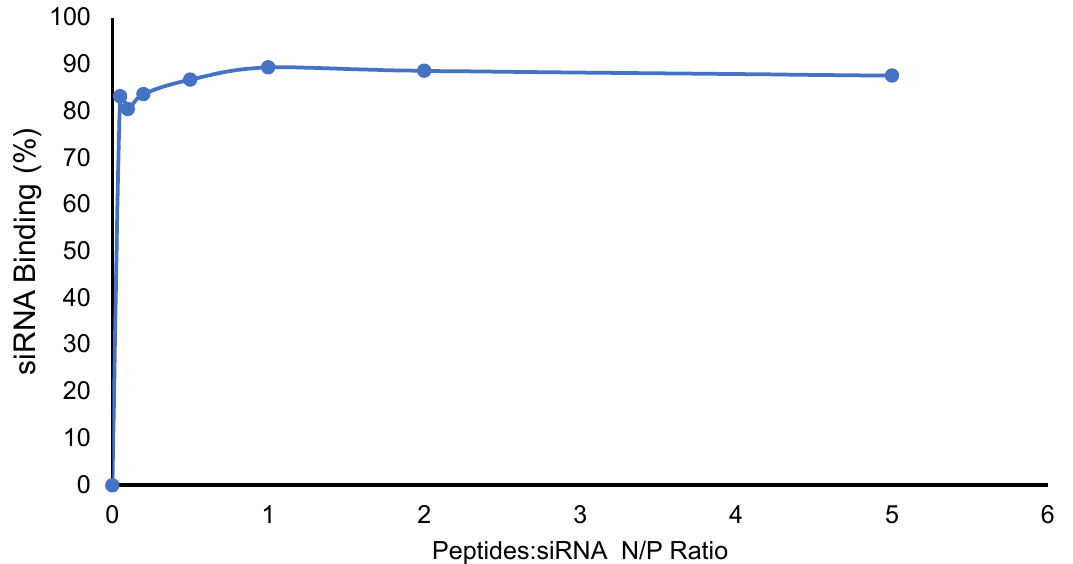
Figure 2. TEM images of [(WR) 5 C] - GdNPs ( a , c ), [(WR) 5 C] - GdNPs-loaded siRNA( b , d ).